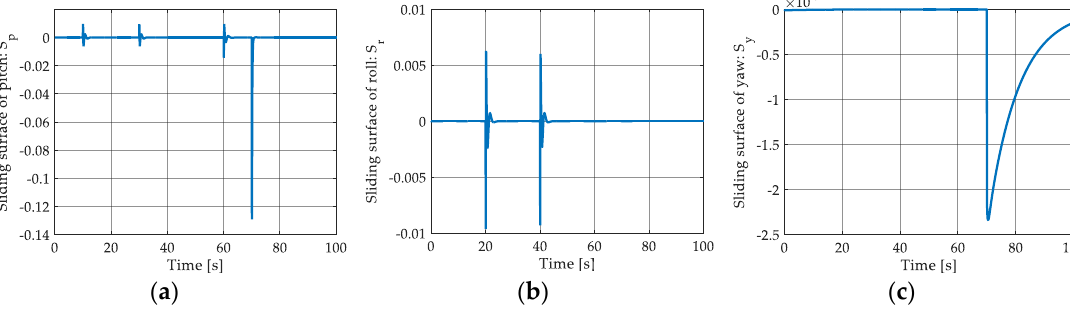
Figure 12. Tracking performance of Euler angles: ( a ) Pitch angle; ( b ) roll angle; ( c ) yaw angle.